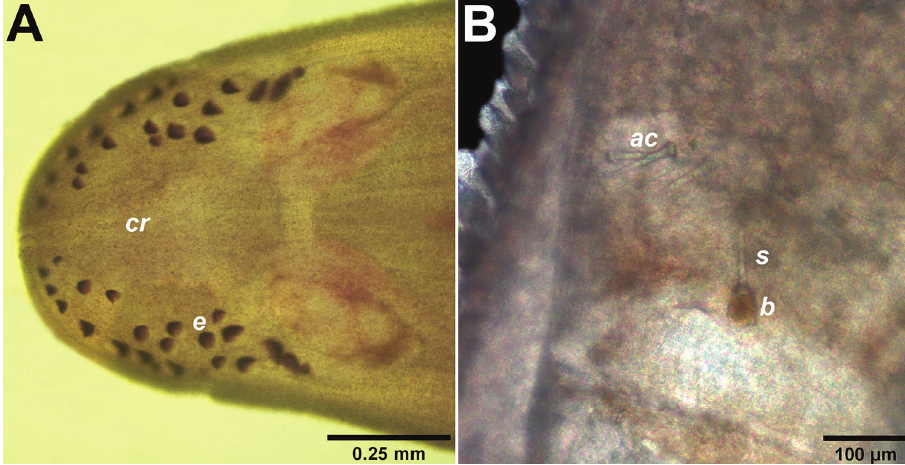
Figure 2. Nipponnemertes incainca sp. n. A Detail of ocelli B Microscopic detail of stylet and